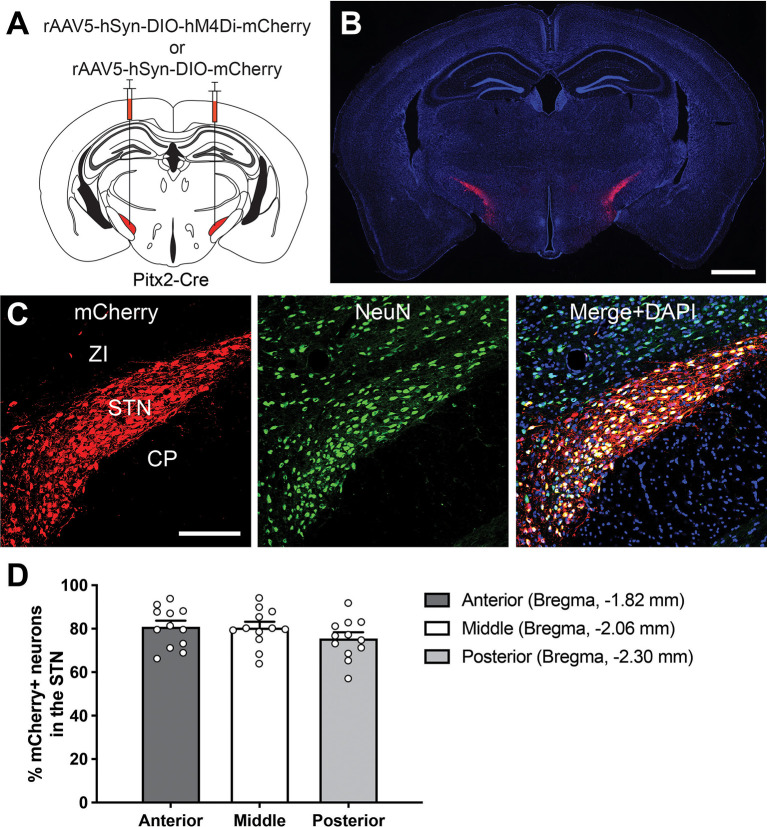
Selective and efficient genetic manipulation of STN neurons. (A) A schematic illustrating adeno-associated virus (AAV) vector injection into the Pitx2-Cre mouse brain. The drawing is adapted from The Mouse Brain in Stereotaxic Coordinates (Paxinos and Franklin, 2004). (B) A representative coronal brain section after rAAV5-hSyn-DIO-mCherry injection. The reporter fluorescence of mCherry enhanced by immunolabeling (red) was observed in the STN. DAPI (blue) was used for the counterstain. Scale bar, 1 mm. (C) Fluorescence imaging of mCherry enhanced by immunolabeling (red) and NeuN immunoreactivity (green). DAPI (blue) was used for the counterstain. Scale bar, 200 μm. (D) Quantification of the percentage of total mCherry-labeled neurons in the anterior, middle, and posterior STN (12 areas each from six mice). CP, cerebral peduncle; STN, subthalamic nucleus; ZI, zona incerta.